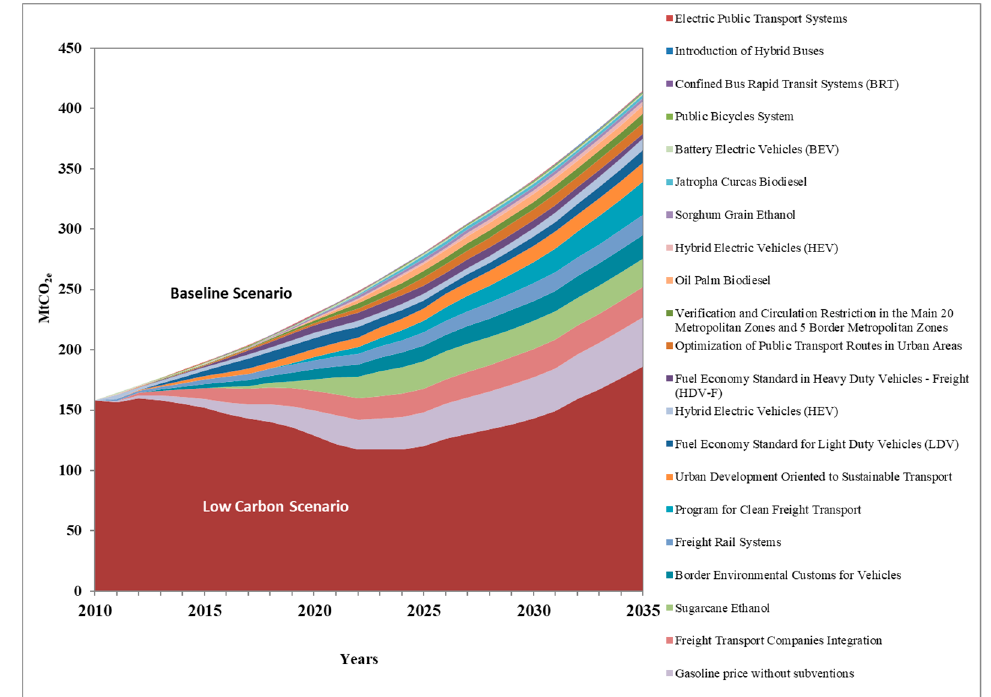
Figure 7. GHG emissions’ reduction by measure in the LCS.